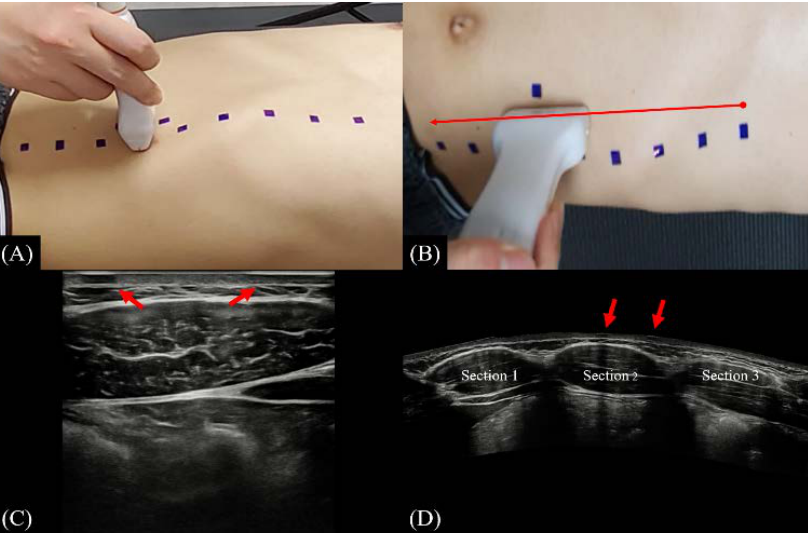
Figure 3. B-mode and EFOV scanning positions and representative images of each method. ( A ) B-mode scan; ( B ) EFOV scan; ( C ) Representative image of RA acquired using B-mode scan; ( D ) Representative image of RA acquired using EFOV scan. The arrow line in ( B ) is the direction of transducer movement during EFOV scanning. The red arrows in ( C , D ) indicate the shading images by absorptive markers. Abbreviations: RA, rectus abdominis; B-mode, brightness mode; EFOV, expanded field of view.